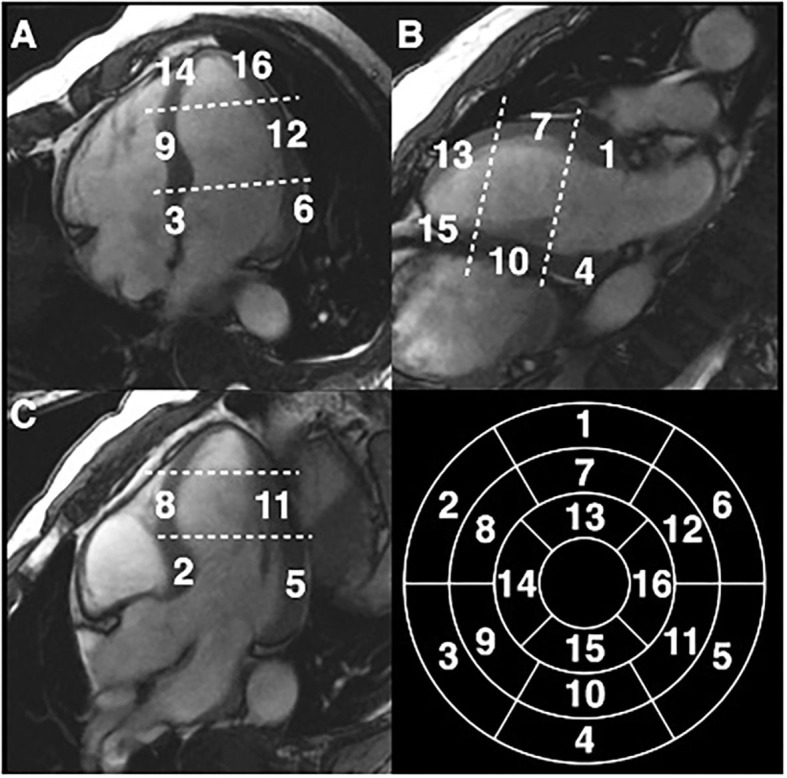
Measurement of NC/C ratios in EuroCMR Registry in 16 segments of the American Heart Association model excluding the true apical cap (segment 17). (A) Four chambers view, (B) two chambers view, (C) three chambers view.